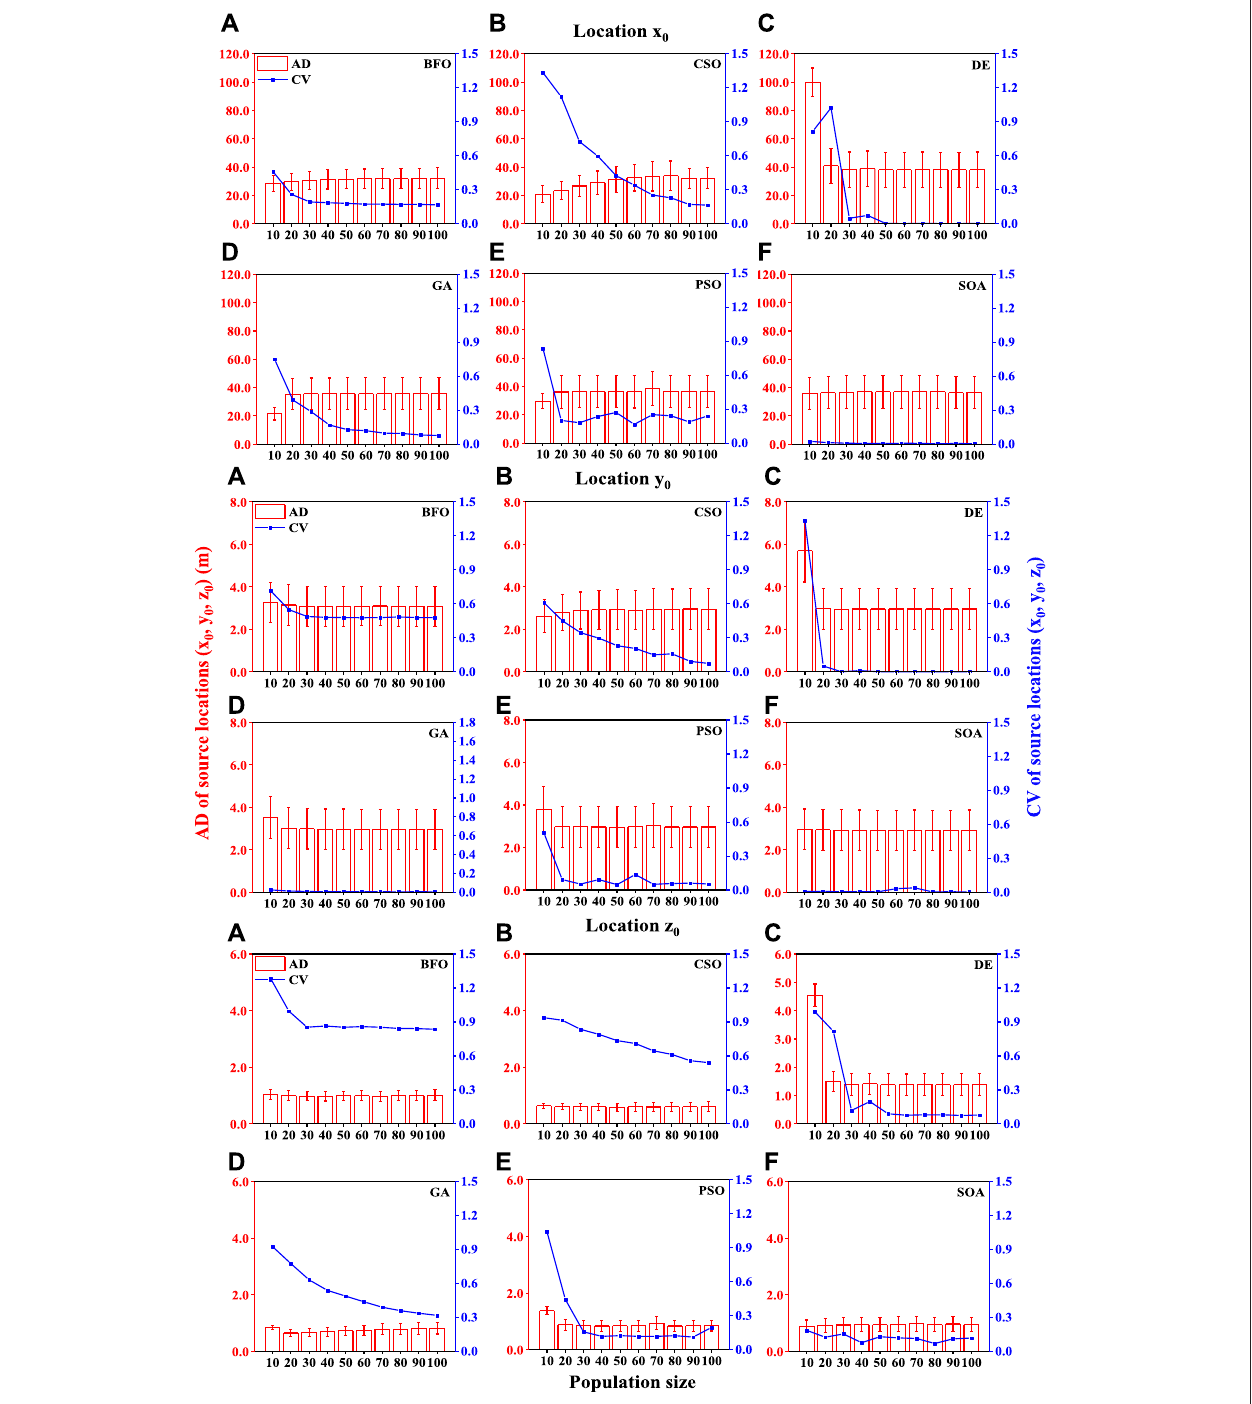
FIGURE 3 | Inversion performance (ADs and CVs) of the BIOs (BFO, CSO, DE, GA, PSO, SOA) for estimations of source locations (x 0 , y 0 , z 0 ) under all tested population sizes for different atmospheric conditions (A – F) .